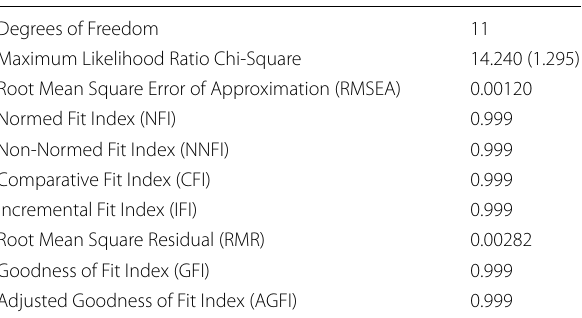
Table 5 Goodness-of-fit